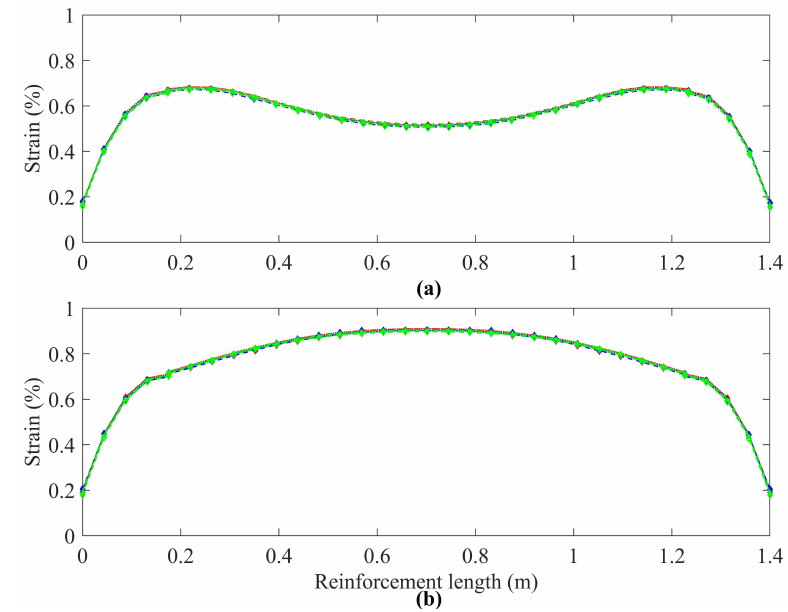
Figure 4. Effect of the widths of strip load ( w = 0.175, 0.3, 0.7 m) on reinforcement strains of SGC mass, under p of 600 kPa, compaction procedure Type-III and q of 10, 30, 44, 60 and 70 kPa—for reinforcements at depths: ( a ) 0.4 m; and ( b ) 1.2 m, from the top surface.